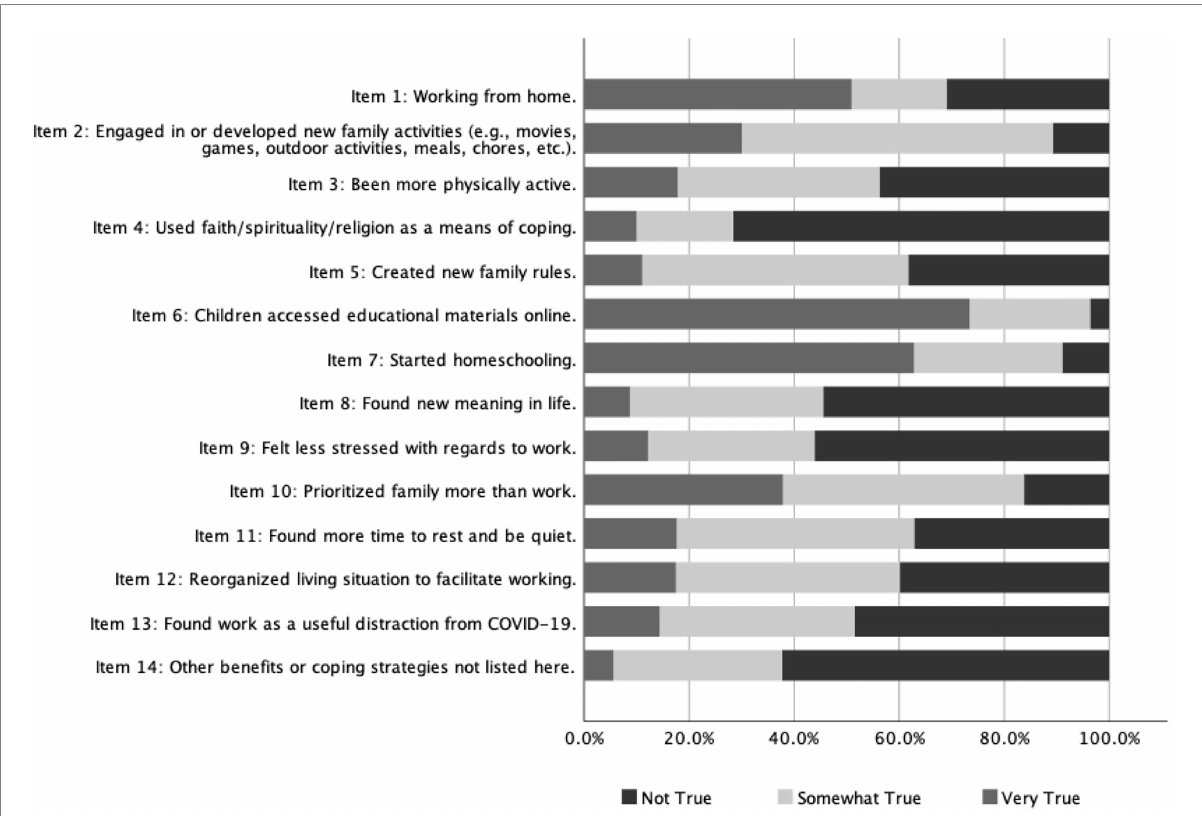
FIGURE 1 Frequency distribution of responses from the Family PACS item pool. Family PACS, Family Positive Adaptation during COVID-19